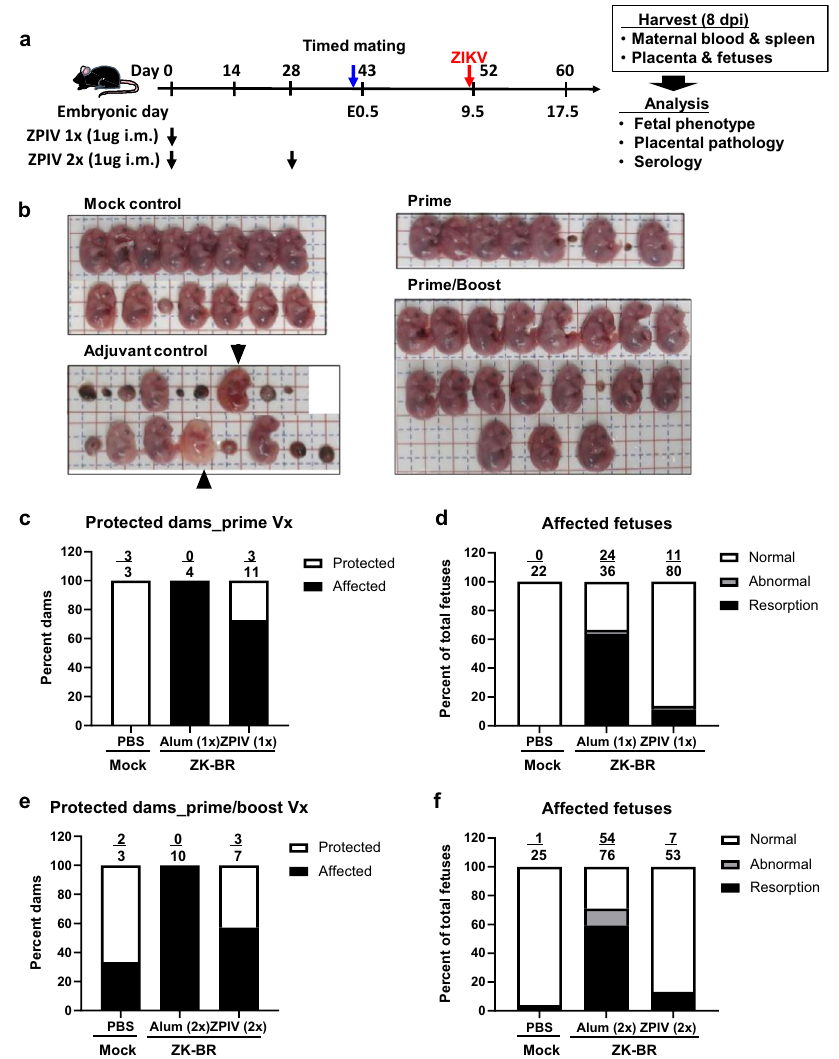
Fig. 1 Protective effect of ZPIV after prime or prime/boost vaccination. a The experimental scheme. Six-week-old female wild-type C57BL/6 mice were intramuscularly (i.m.) injected with alum adjuvant alone, or 1 ug alum-adjuvanted ZPIV with either a one (at 0 week) or two (at 0 and 4 weeks) dose regimen. Two weeks after the last vaccination, females were mated and challenged at embryonic day 9.5 (E9.5) with 6 × 10 5 PFU ZK-BR and examined at 8 dpi (E17.5). b Representative images of fetal phenotypes per group. The horizontal and vertical lines in the grid mark 5 mm intervals. Note macerated fetuses with abnormal vascular development (arrowheads) and extensive fetal demise after ZIKV challenge of mice that received adjuvant alone. The percentage of dams bearing fetuses with normal phenotype after prime ( c ) or prime/ boost ( e ) vaccination. The numbers above the individual bar indicate the number of dams without any fetal abnormality over the total number of dams examined per group. The percentage of affected fetuses of total fetuses per group after prime ( d ) or prime/boost ( f ) vaccination. The numbers above individual bars indicate the number of affected fetuses over the total number of fetuses per group. The percentage of fetal abnormality was analyzed using Fisher ’ s exact test. The difference between the alum only and the ZPIV vaccinated group was signi fi cant, P < 0.0001 but not between the mock-infected and the prime/boost vaccinated groups ( P >